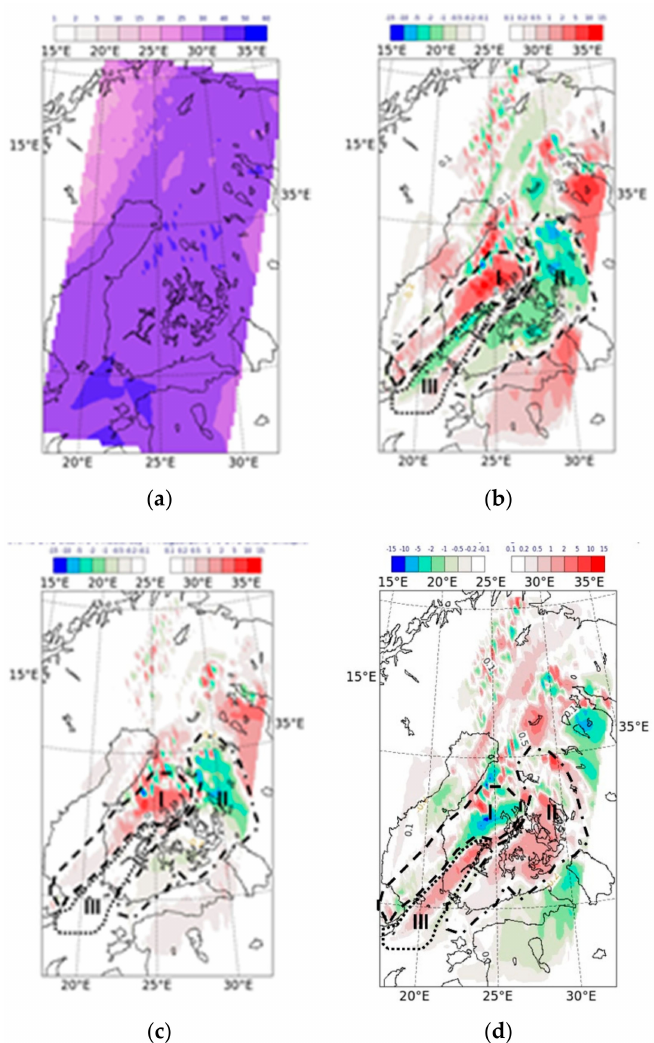
Figure 4. Spatial distribution of precipitable water over the Finnish domain for 18:00 UTC 14 August 2010. ( a ) in analysis and differences between runs: ( b ) FINE-CNTR, ( c ) COARSE-CNTR, ( d ) COARSE-FINE. Areas I, II, and III outline specific regions in redistributing of precipitable water. The RDA procedures change also the vertical distribution of rain water in the atmosphere. Figure 6 shows the vertical profiles for this variable in the area of the largest differences between the FINE and COARSE runs. The former is similar, in its general features, to the control run, but slightly redistributes water from a 2.5 to a 3.5 km layer towards lower levels. This can produce rare ripe condensation and a decrease of downstream precipitation in favor of upstream, which is shown in Figure 4b. The COARSE run shows a significant reduction of water content in the area, which is explained by the following two reasons. The first is that the deep smoothing spreads a compact substance (water cell) over larger neighboring areas and decreases its concentration. The second, which is related to the above, is that the smoothing changes the water (vapor) concentration, which follows changes in a chain of microphysical processes. The detailed study of links in this chain is a subject of ongoing